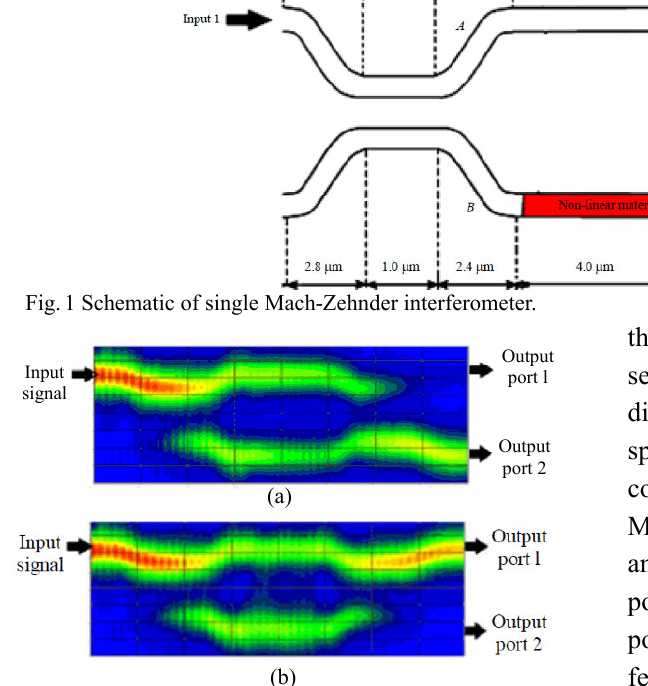
Fig. 2 Propagation of light through single MZI: (a) for low intensity signals and (b) for high intensity signals.